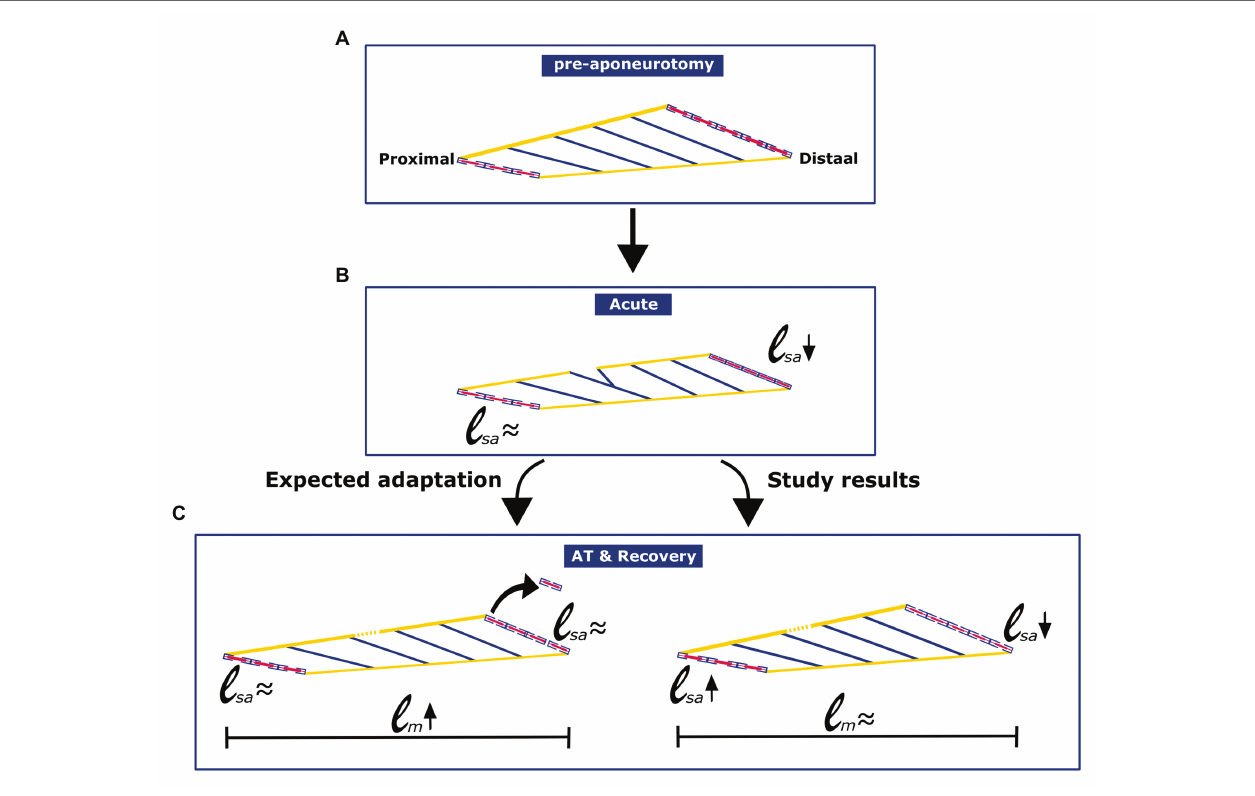
FIGURE 8 | Schematic figure illustrating the effects of aponeurotomy acutely and in long term, as was expected, and as was found in current study. (A) Pre- aponeurotomy: Distally located muscle fibers have higher number of serial sarcomeres than proximally located fibers. (B) Acute: Acutely after the aponeurotomy, distal muscle fibers mean sarcomere length decreased, while the length of proximal fibers was unchanged (Jaspers et al., 1999). (C) AT & Recovery: Adaptation after aponeurotomy and recovery was not as expected from the general rules of adaptation. In distally located muscle fibers, numbers of sarcomeres in series were similar to that of fibers from the control group. However, distal muscle fibers mean sarcomere length remained